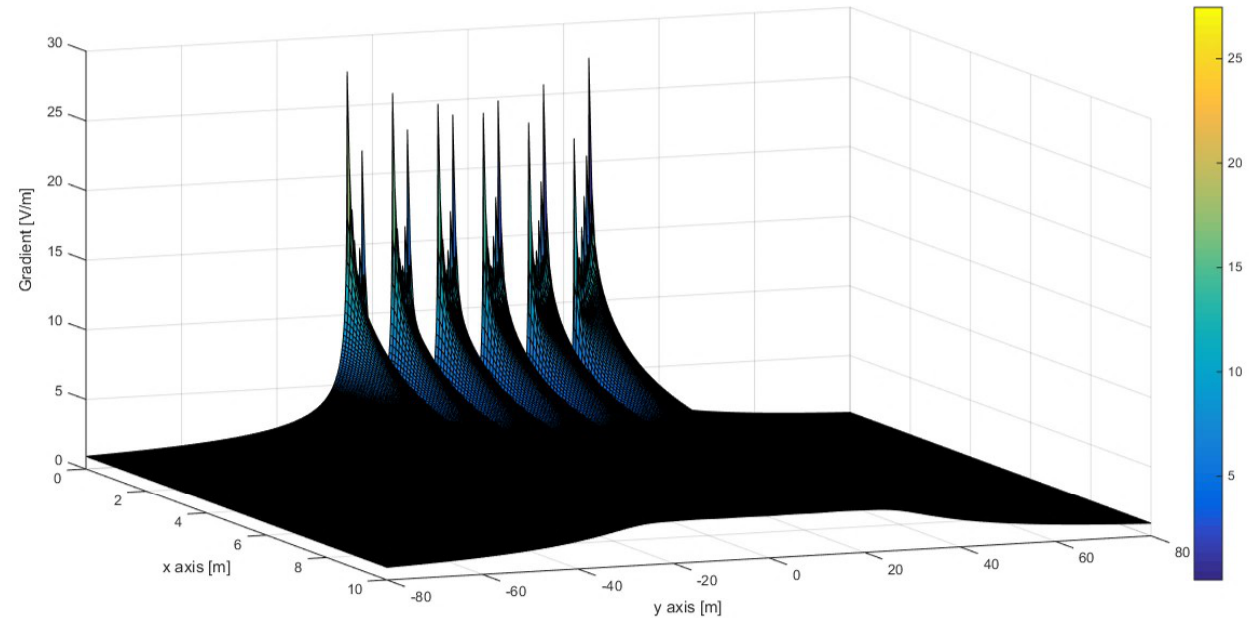
Figure 22. Electric field strength for method “C”, of linear current source, for an electrode station of 6 linear frames in a row with d frames = 6.50 m; each frame consists of 13 electrodes of active length L = 2.13 m, D el = 0.50 m, ρ w = 0.25 Ω · m, θ = 248 ◦ (area of Korakia), J full_load_steady = 18.33 A/m 2 (steady state and operation of all 6